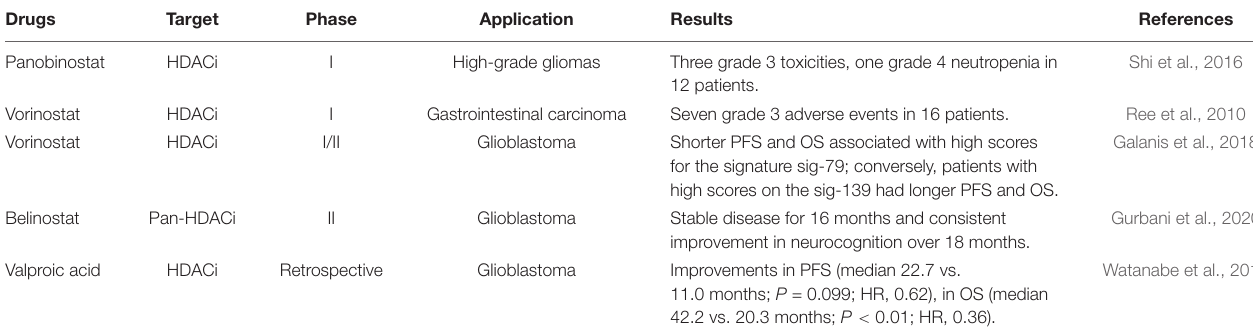
TABLE 2 | Epigenetic drugs for radiotherapy enhancement.